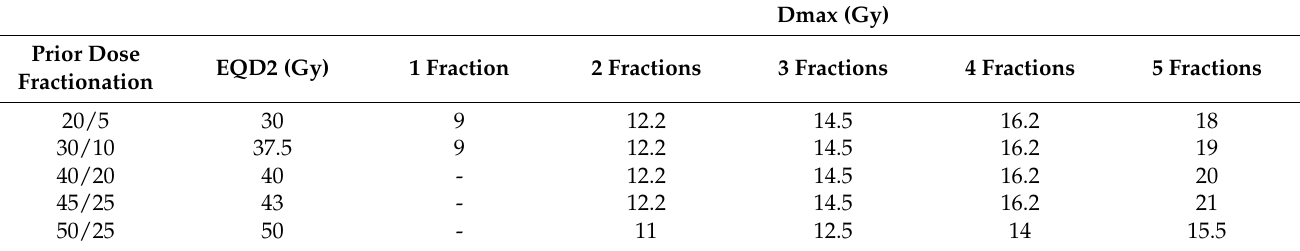
Table 5. Recommendations for reirradiation, taking into account prior conventional EBRT–Maximal proposed spinal cord Dmax was derived from criteria associated with no RM case in Sahgal’s study